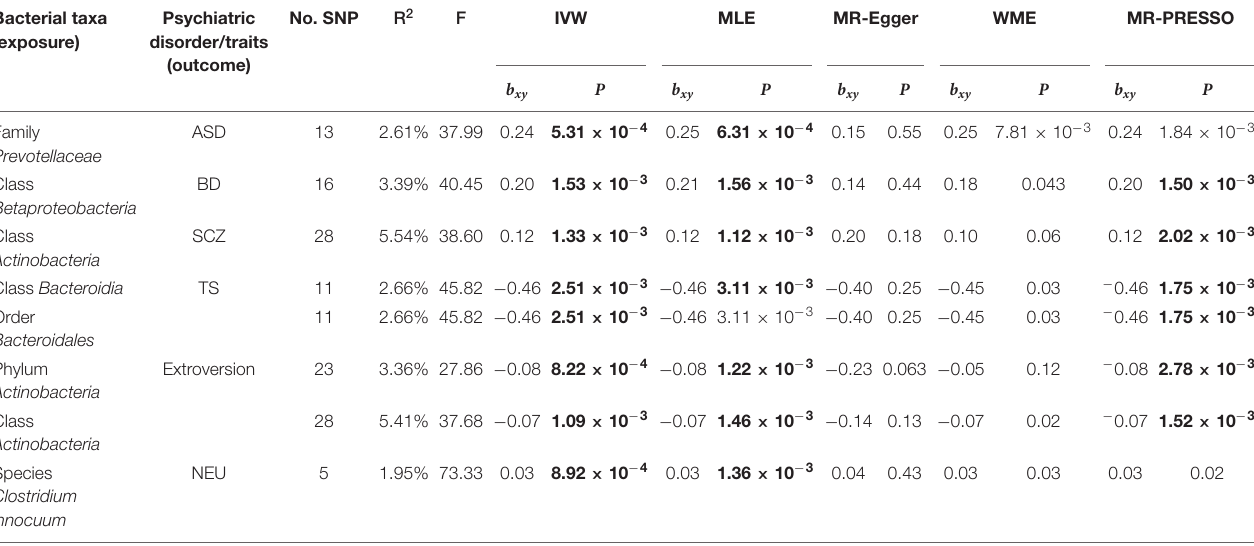
TABLE 2 | Causal estimations of gut microbiota on psychiatric disorders in the MR analysis. Bacterial taxa Psychiatric No. SNP R 2 F IVW MLE MR-Egger (exposure) disorder/traits (outcome)